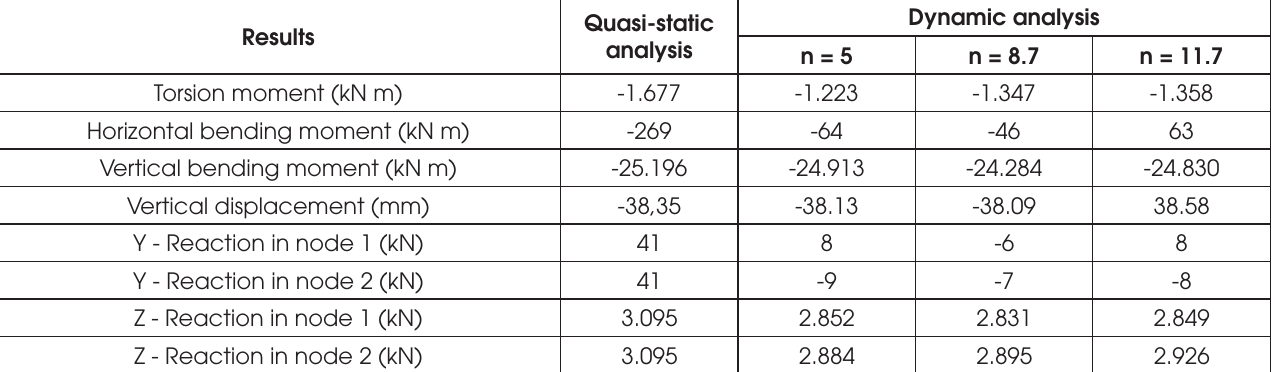
Table 4 Maximum values obtained by each analysis